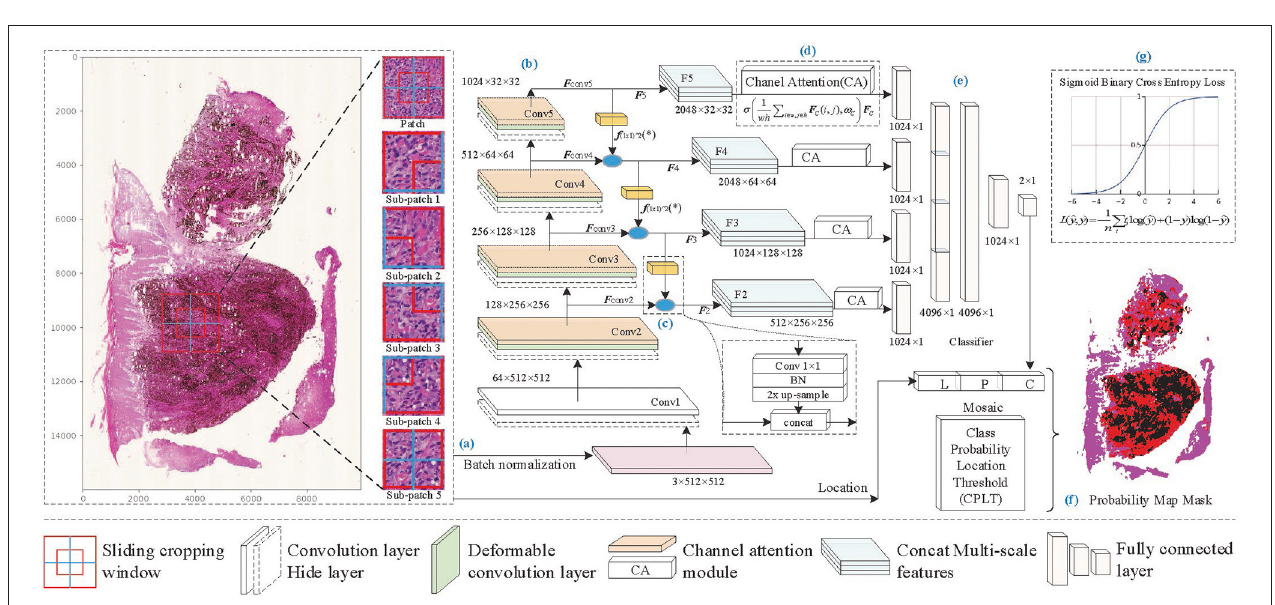
FIGURE 1 | The idea of the proposed method. The WSI is broken up into patch images. The classification results are aggregated and generate the mosaic-type mask based on the probability map, and the MM regions are segmented based on a settable probability threshold.